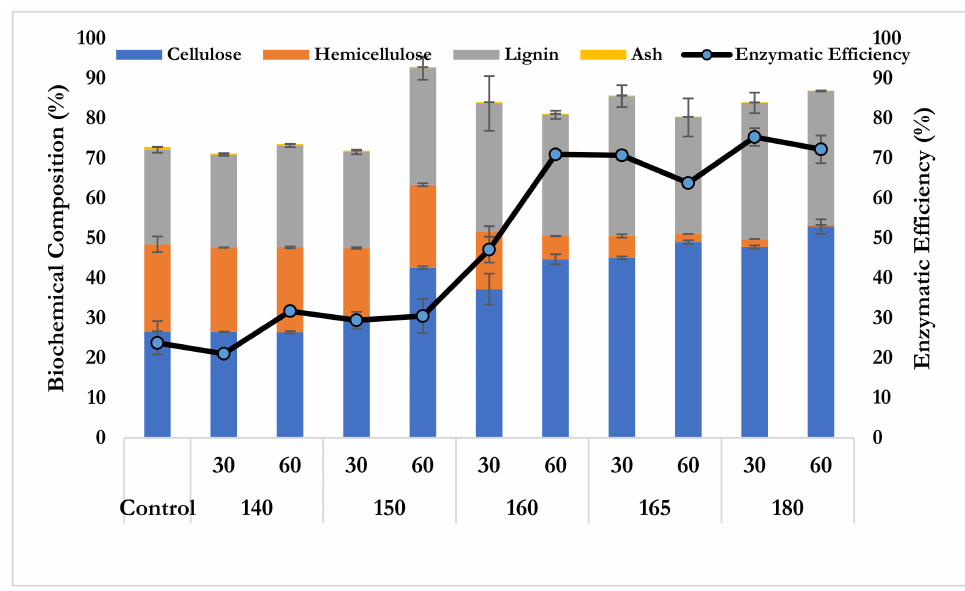
Figure 1. The biochemical composition and enzymatic hydrolysis efficiency of corncob pretreated by the hydrothermal